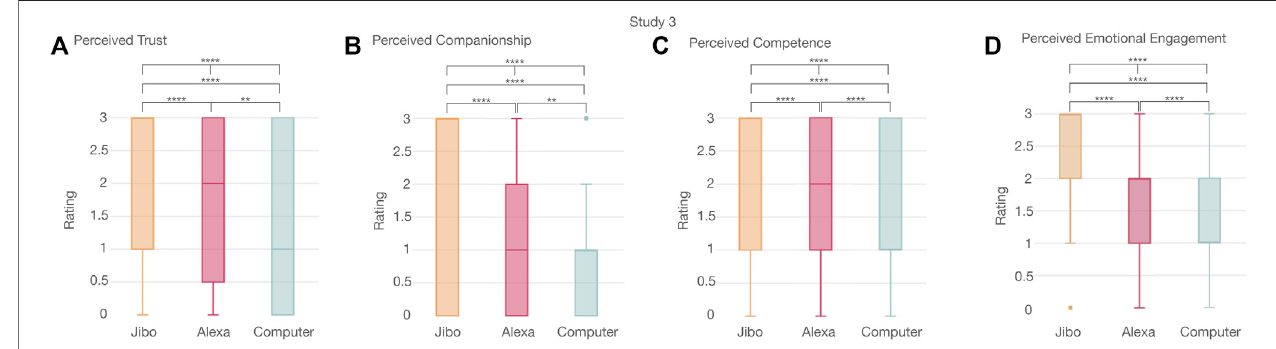
FIGURE12| Signi fi canttrendinperceivedtrust,companionship,competence,andemotionalengagementofvoiceagentsbetweenparticipantsshowingJibowas signi fi cantlyperceivedas (A) moretrustworthy, (B) morelikeacompanion, (C) morecompetent,and (D) moreemotionallyengagingthanAlexaorComputer.Alexawas perceived as (A) more trustworthy, (B) more like a companion, (C) more competent, and (d) more emotionally engaging than